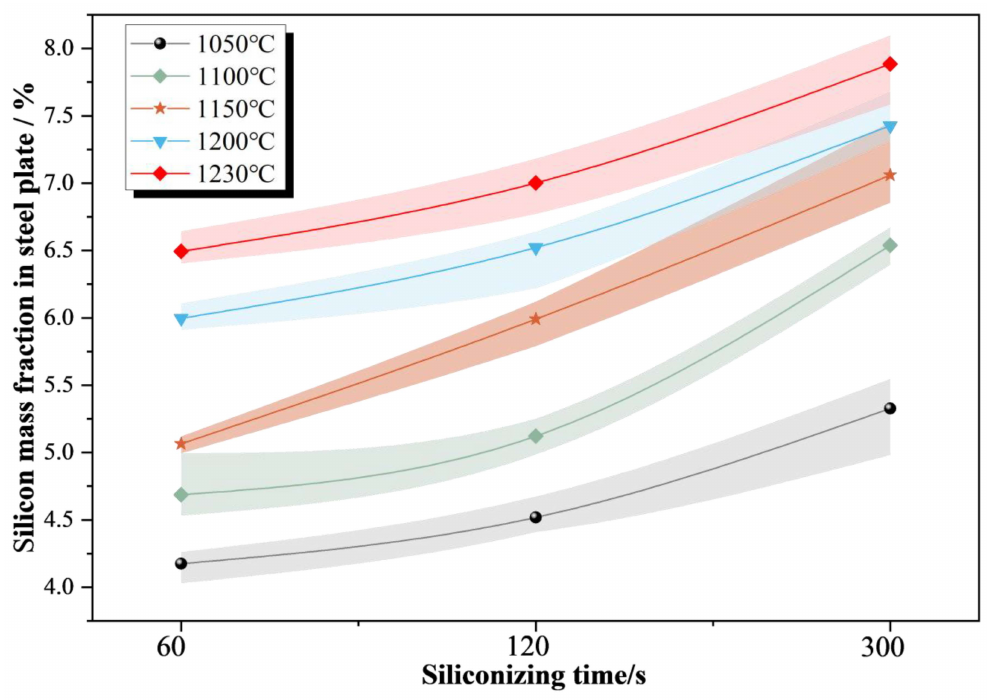
Figure 5. The mass fraction of silicon in the steel plate after silicon infiltration at different temperatures and